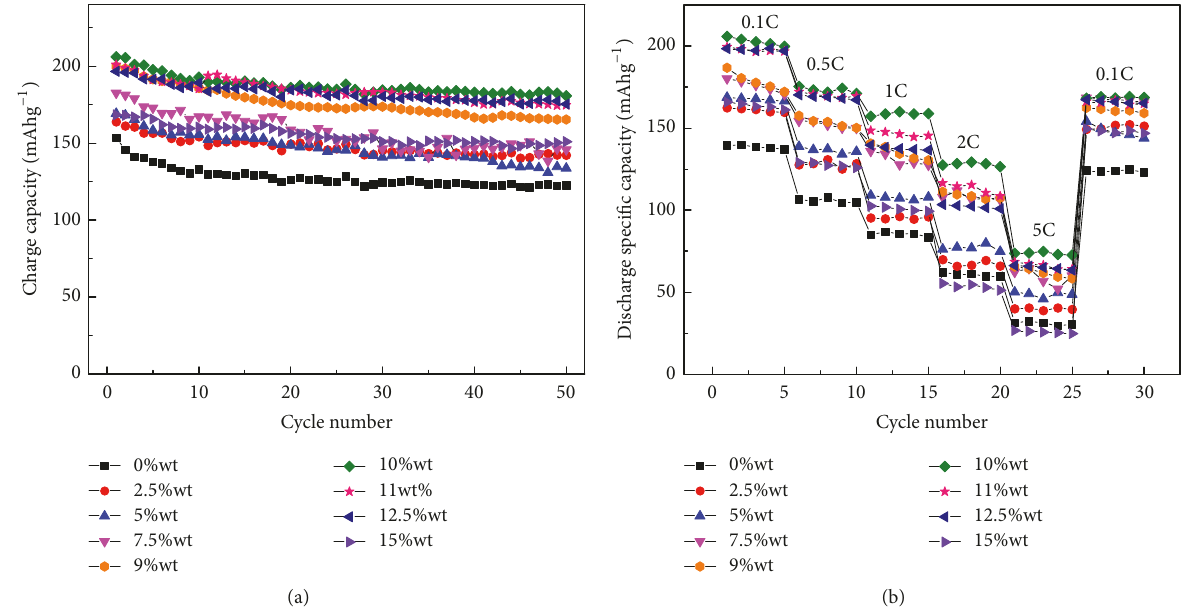
Figure 4: (a) Charge curves of pristine and PVA-auxiliary lithium-rich manganese-based cathode materials at 0.1 C; (b) rate capabilities of the x = 0.0–15.0 wt% cathodes.